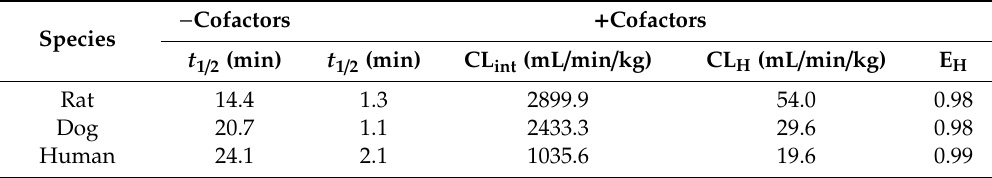
Table 5. Predicted hepatic metabolic stability of SP-8356 in rats, dogs and humans.